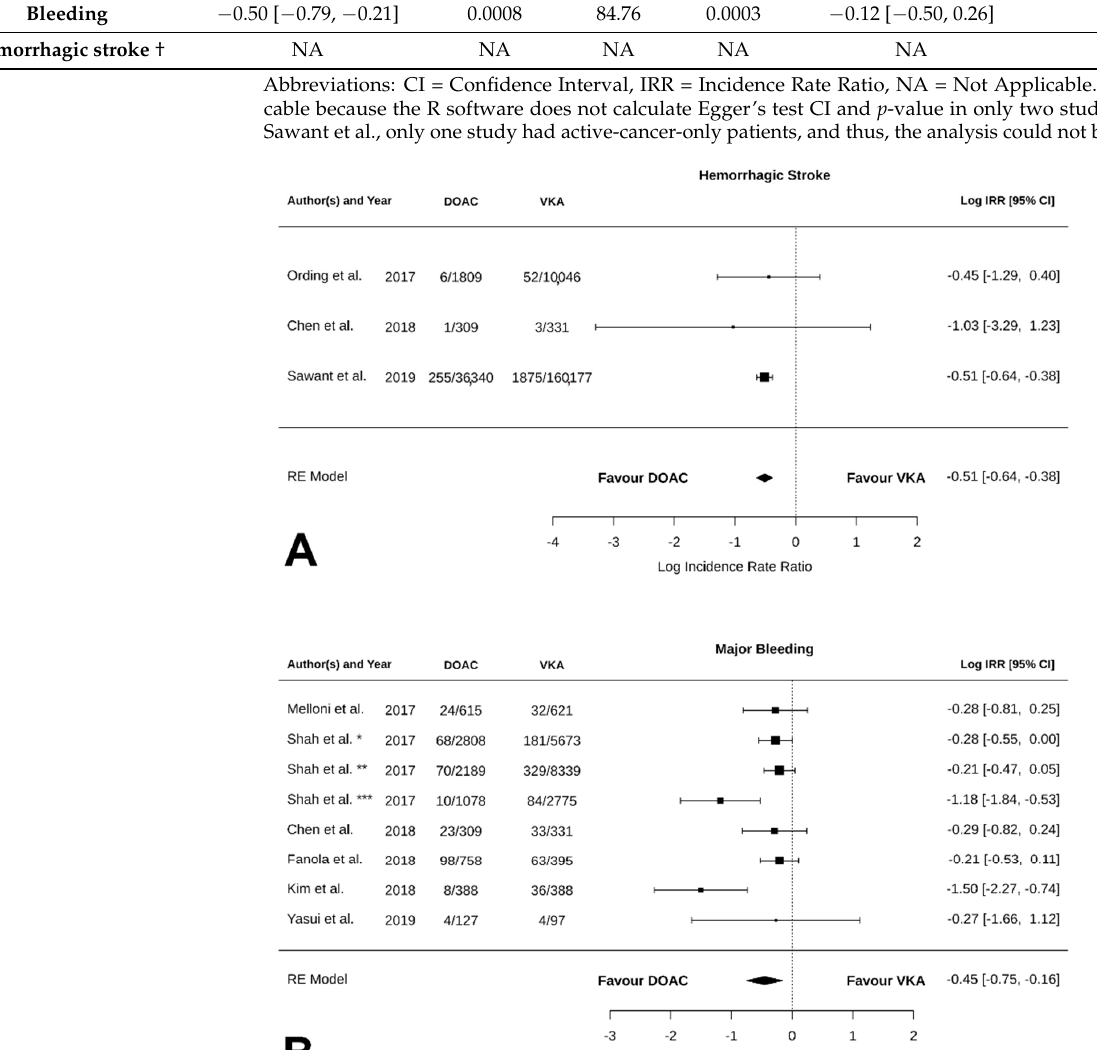
Figure 4. Forest plot of the IRR for safety outcomes in VKAs versus DOACs. ( A ). Hemorrhagic stroke. ( B ). Major bleedings. ( C ). Clinically relevant non-major bleeding. * rivaroxaban, ** dabigatran, *** apixaban [19,27,29–32]. As reported in Figure 4B, the log IRR for major bleeding was − 0.45 [95% CI: − 0.75, − 0.16] ( p = 0.03; I 2 = 69.89%, p = 0.02; Egger’s test: intercept 0.06 [95% CI: − 0.38, 0.49], p =